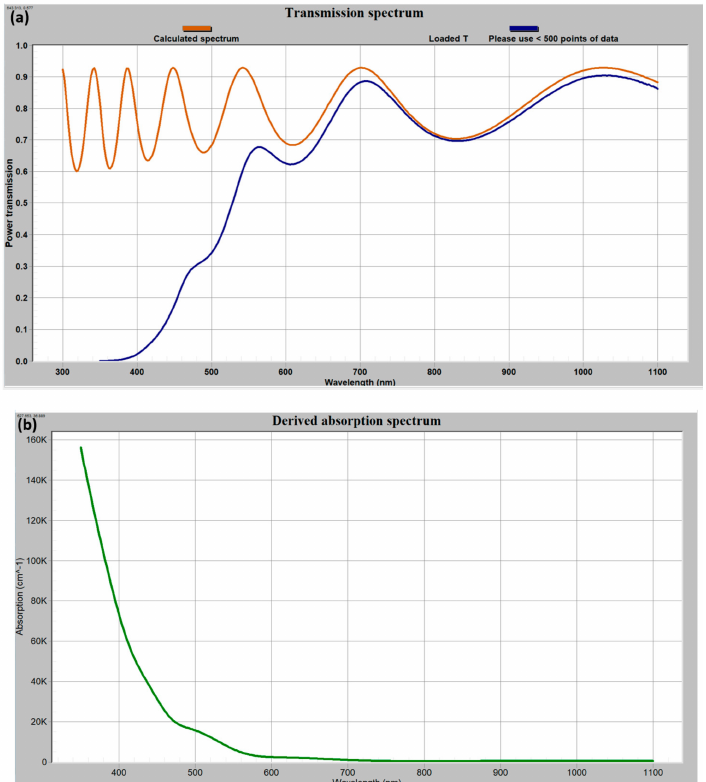
Figure 8. Iterative (bisection algorithm-assisted) fitting of the absorption coefficient spectral dependency and the required pre-fitting of film thickness through matching transmission peak features. ( a ) Peak-aligned transmission spectrum pre-fitting result, from which the physical film thickness information and the measured dataset on the refractive index dispersion are then used, within the option available in the “Inverse Problem” menu, to derive the absorption coefficient data; ( b ) the algorithm-derived (fitted) absorption coefficient spectrum ( α , cm − 1 ) for 481 nm thick as-deposited Bi 0.9 Lu 1.85 Y 0.25 Fe 4.0 Ga 1 O 12 garnet-precursor film sample on a glass substrate (its measured transmission spectrum is shown as blue curve in